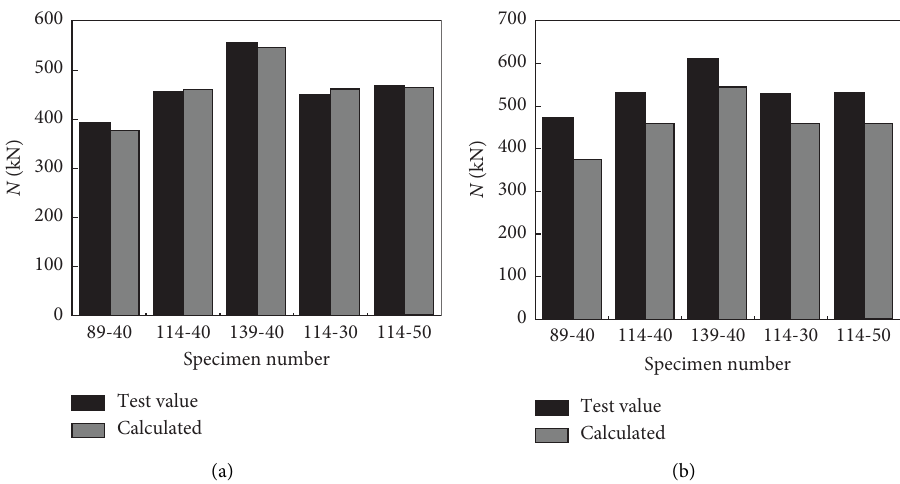
u 10000 test value and calculated value comparison